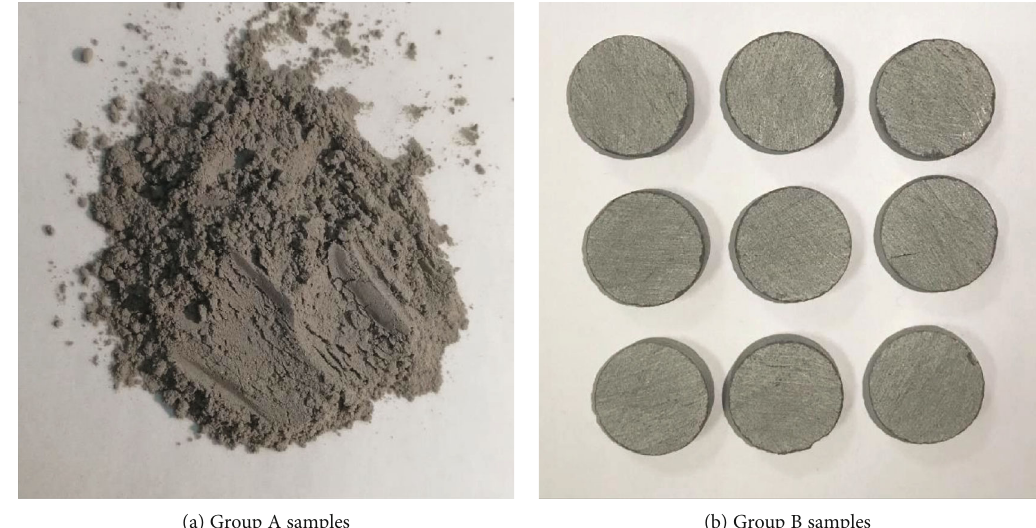
Figure 2: Specimen samples.